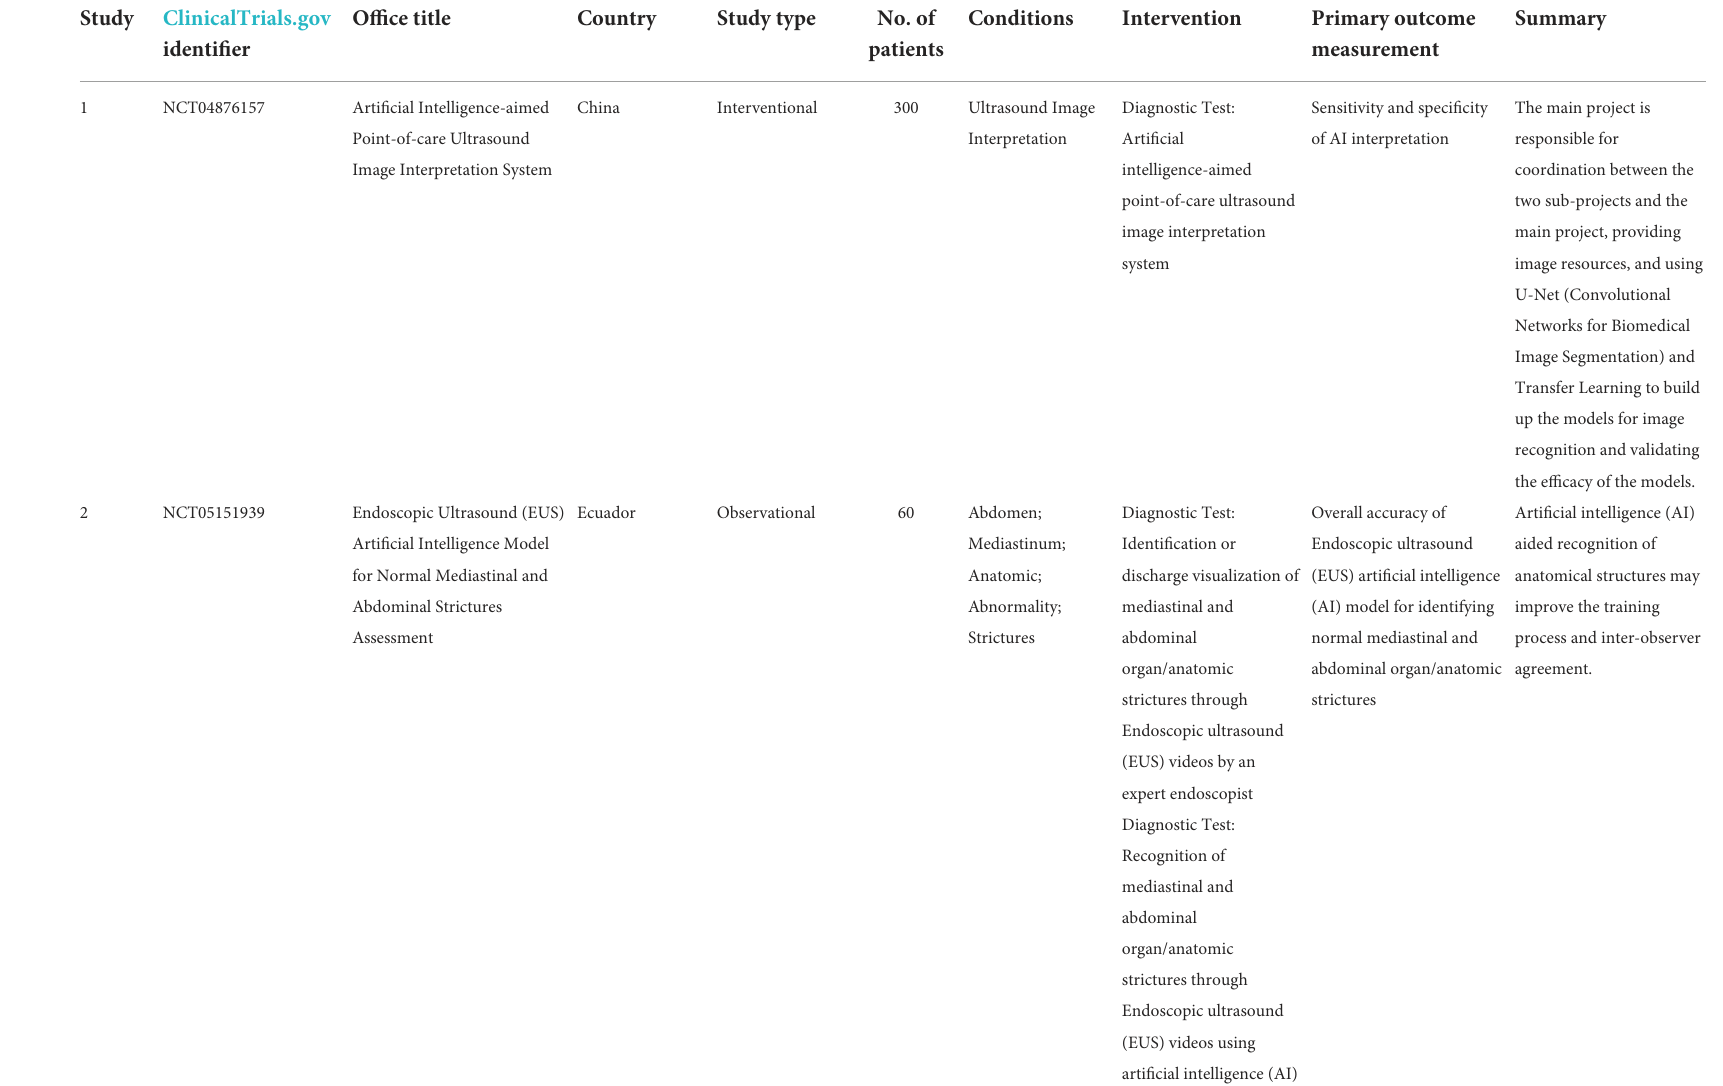
TABLE 6 Clinical trials about AI in